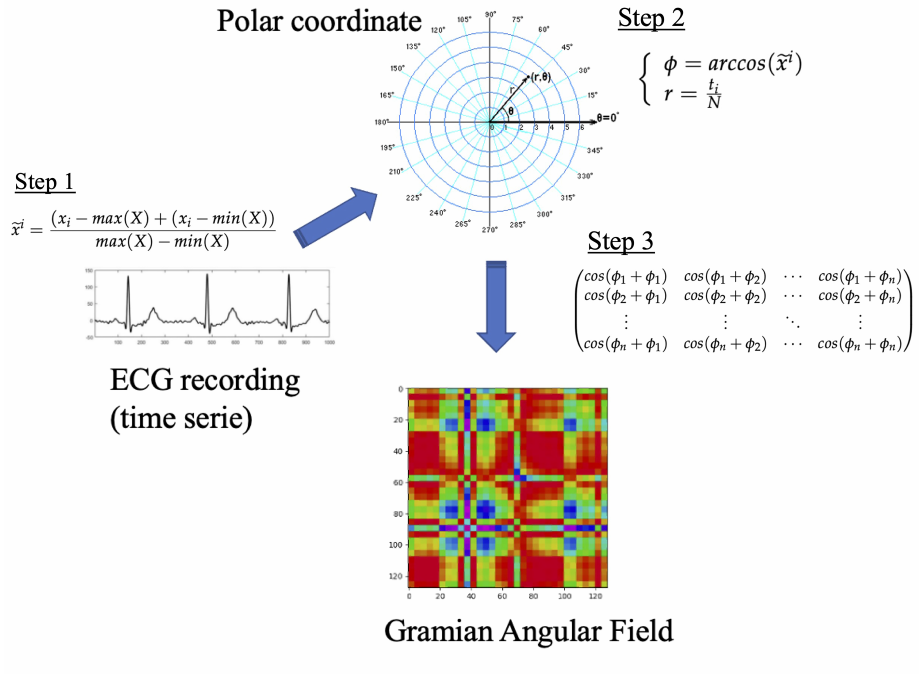
Figure 2. Encoding process of